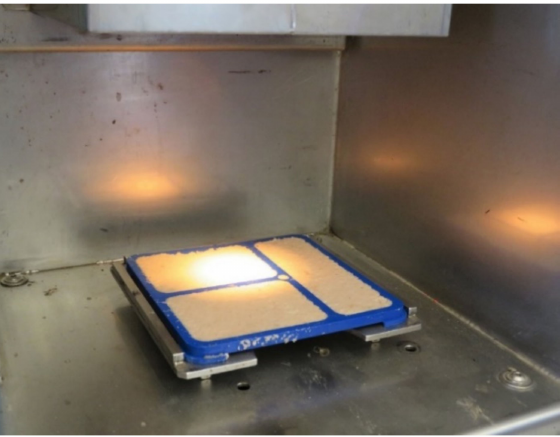
Figure 3. Homogeneous and representative pulp samples from a given field plot being measured with NIR under reflectance. NIR equipment was installed in the